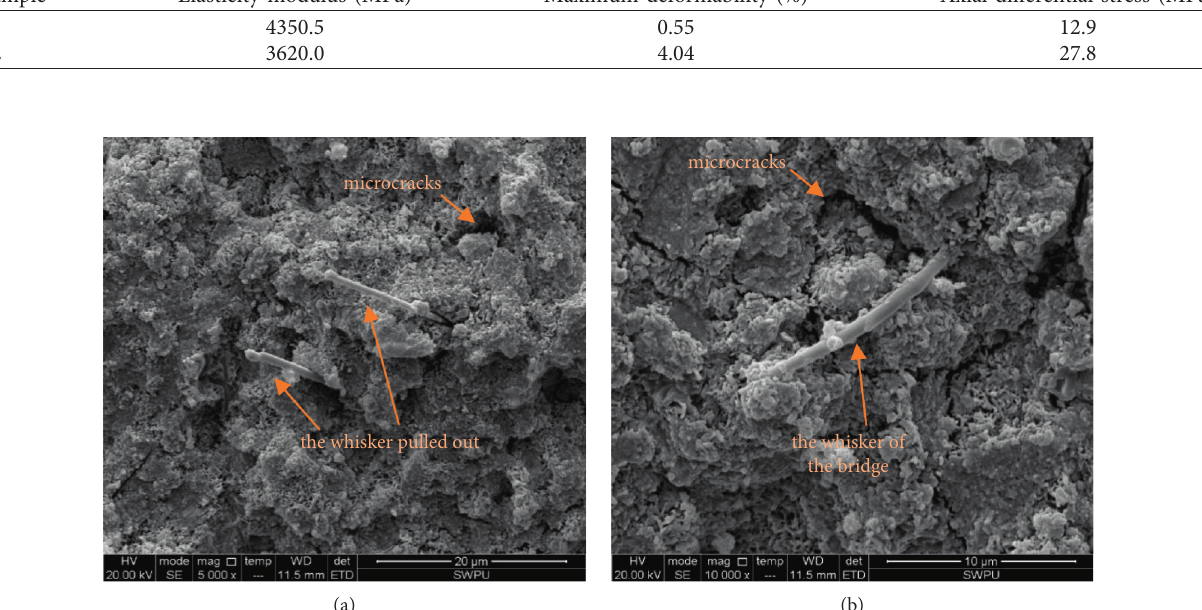
Table 6: Basic parameters of mechanical properties of SiC whisker solidified (S2) and without SiC whisker (V). Sample Elasticity modulus (MPa) Maximum deformability (%) Axial differential stress (MPa)